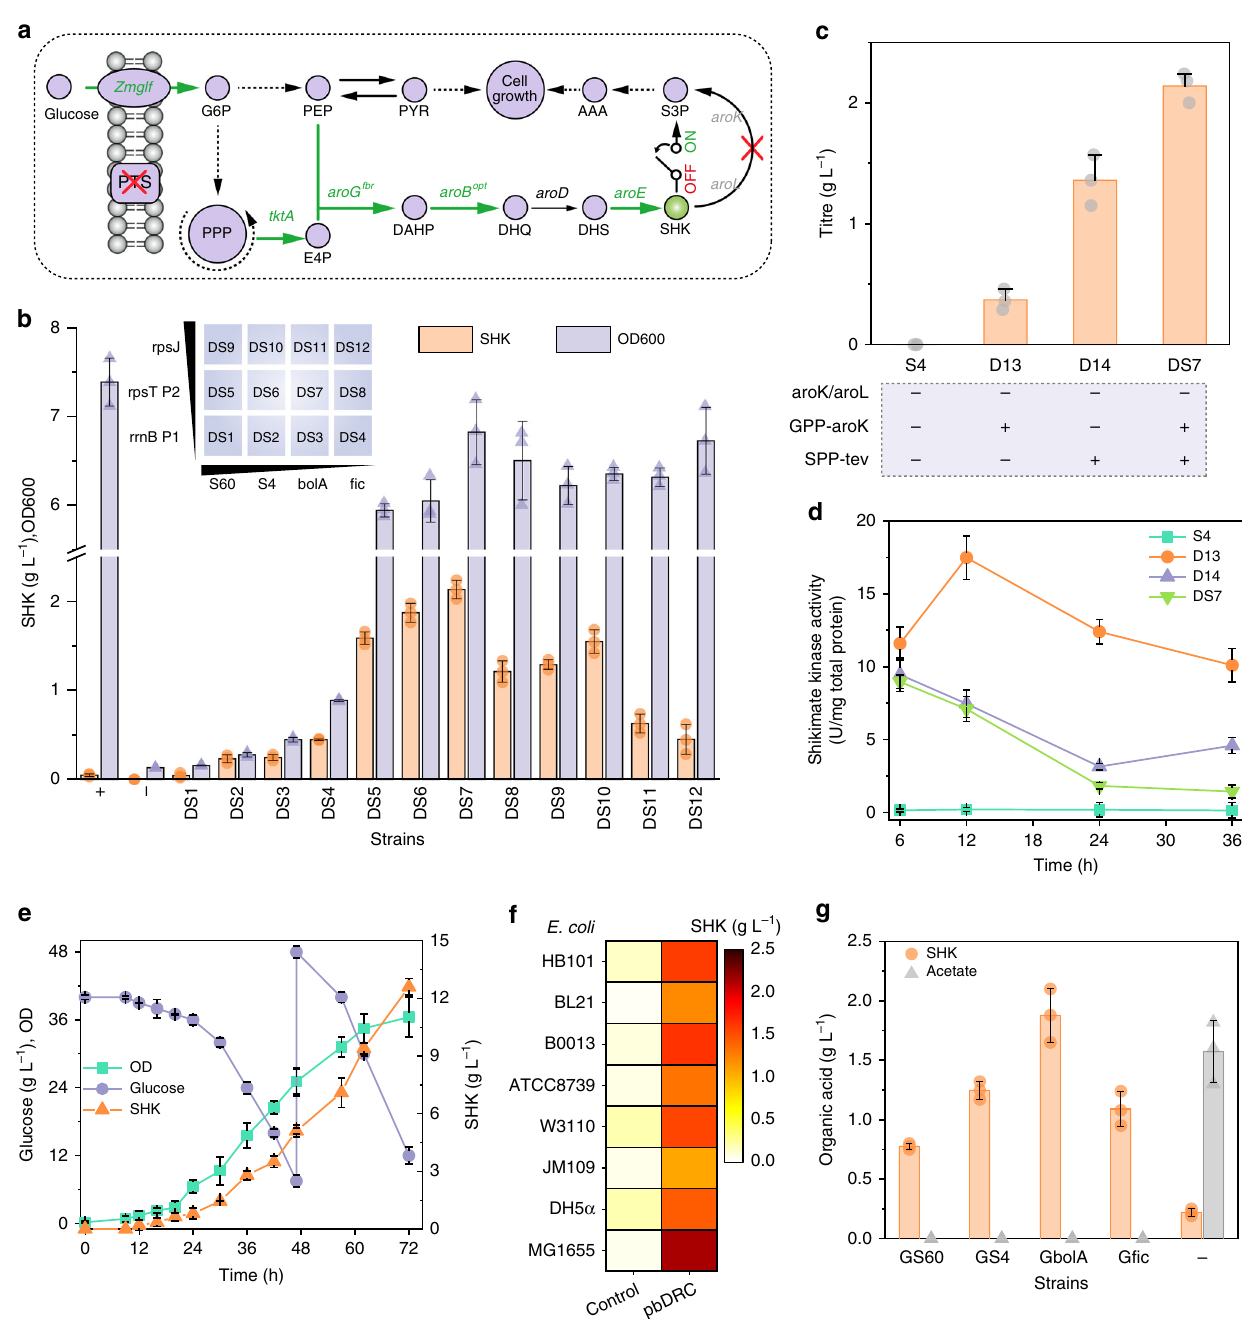
Fig. 5 Dynamic regulation for shikimate production. a Engineering shikimate biosynthetic pathway in chassis E. coli strain S4. Red cross indicated pathway blocking. Genes that are bold were overexpressed. b Effect of different combinations of the pbDRC on titer and cell growth (72 h). + and − represent chassis S4 cultured in NBS medium with ( + ) or without ( − ) AAA supplement. Insert was orthogonality matrix for strains construction. c Titer comparison of different strains in NBS medium without AAA supplement. Insert: aroK/aroL represents the genomic expression of shikimate kinase I/II; GPP-aroK represents the expression of shikimate kinase I under the control of GPP; SPP-tev represents a SPP-based expression of TEVp with a constitutive expression of shikimate kinase I. d Evaluation of shikimate kinase I degradation in different strains during shikimate production. e Shikimate production of engineered strain DS7 in bioreactor. f Titer comparison of different strains and corresponding engineered strains with pbDRC system (72 h). g Genomic- scale dynamic pathway modulation of shikimate production (72 h). – represents strain without expressing TEVp. Values are shown as mean ± SD ( n = 3). aroB opt , DHQ synthase with fi rst eight codons optimized; aroD, DHQ dehydratase; aroE, shikimate dehydrogenase; aroG fbr , feedback-resistant mutants of DAHP synthase (D146N); aroK/aroL, shikimate kinase I/II; DAHP, 3-deoxy-D-arabino-heptulosonate-7-phosphate; DHQ, 3-dehydroquinic acid; DHS, 3-dehydroshikimate; E4P, erythrose-4-phosphate; G3P, glyceraldehyde 3-phosphate; G6P, glucose 6-phosphate; PEP, phosphoenolpyruvate; PTS, phosphotransferase system; PP pathway, pentose phosphate pathway; PYR, pyruvate; SHK, shikimate; S3P, shikimate-3-phosphate; tktA, transketolase A; Zmglf, glucose facilitator from Z. mobilis . Source data of Fig. 5b – g are provided in Source Data fi